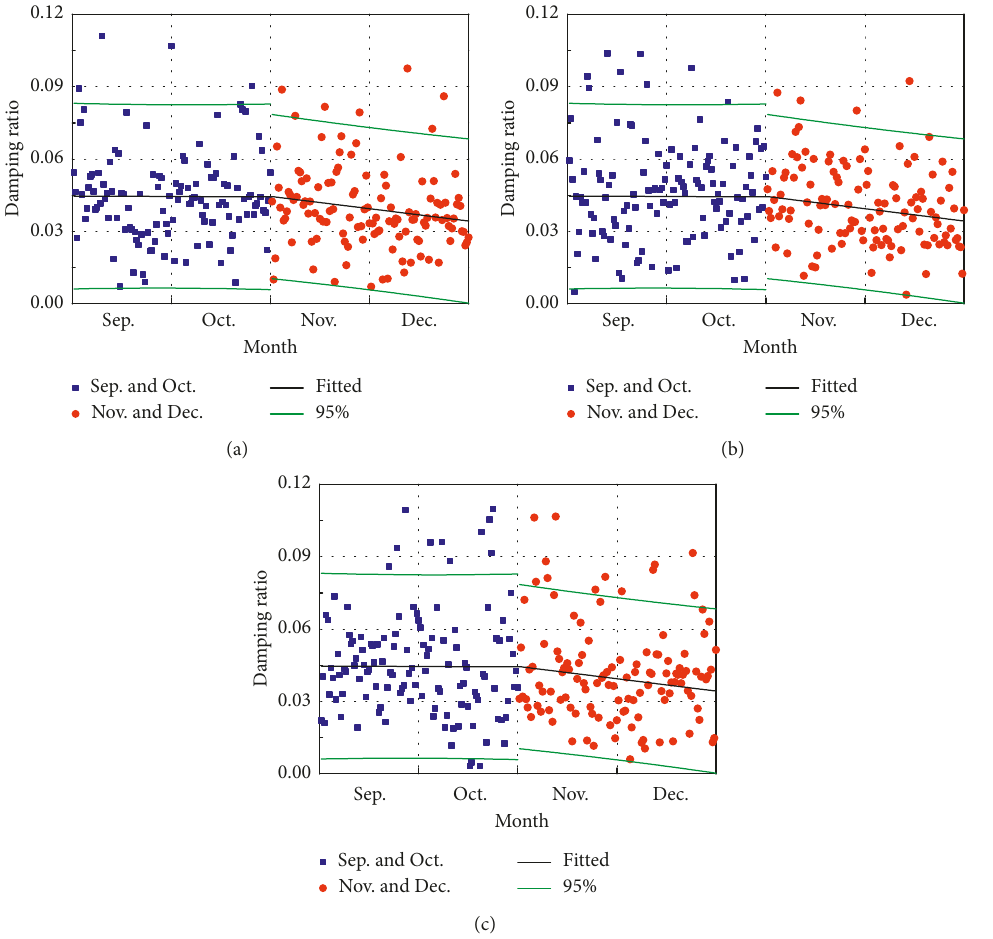
Figure 36: Damping ratio variation versus time: (a) the 1st mode damping ratio (longitudinal); (b) the 2nd mode damping ratio (transverse); and (c) the 4th mode damping ratio